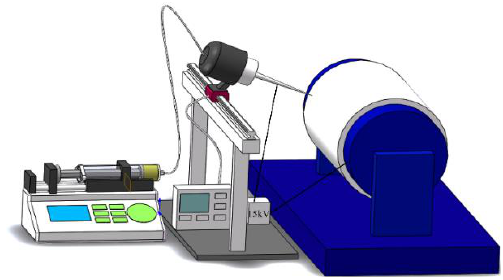
Figure 1. Self-made electrospinning equipment diagram.